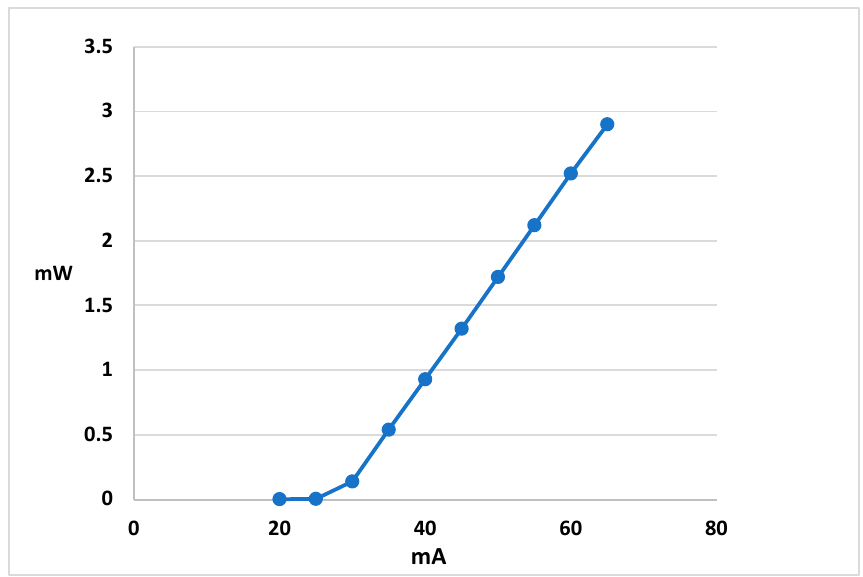
Figure 8. Linear relationship between current and light power of the Blu-ray pickup head.